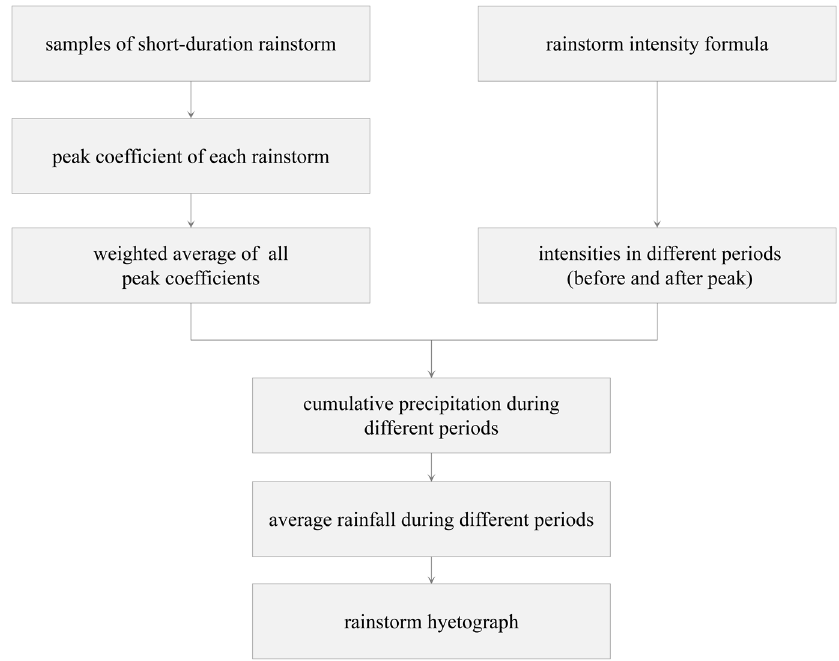
Figure 2. Flow chart of Chicago hyetograph method.